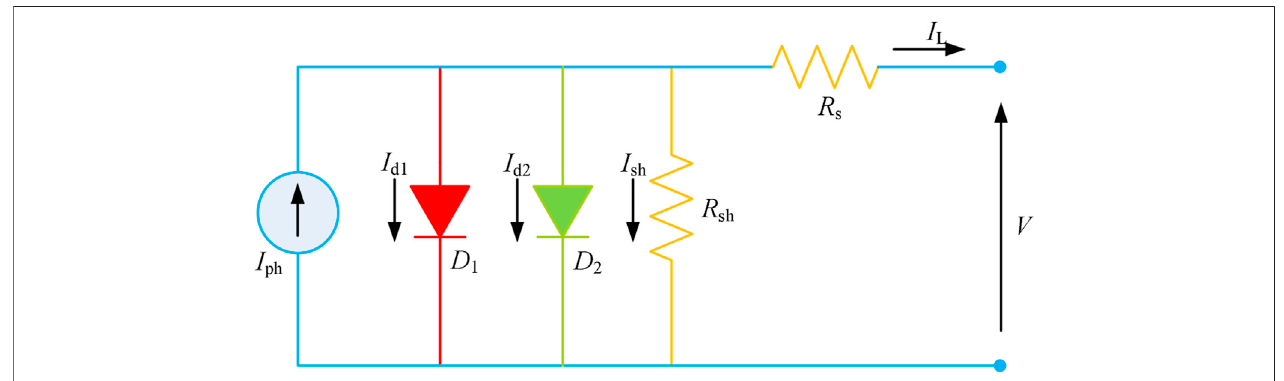
FIGURE 2 | Equivalent circuit of